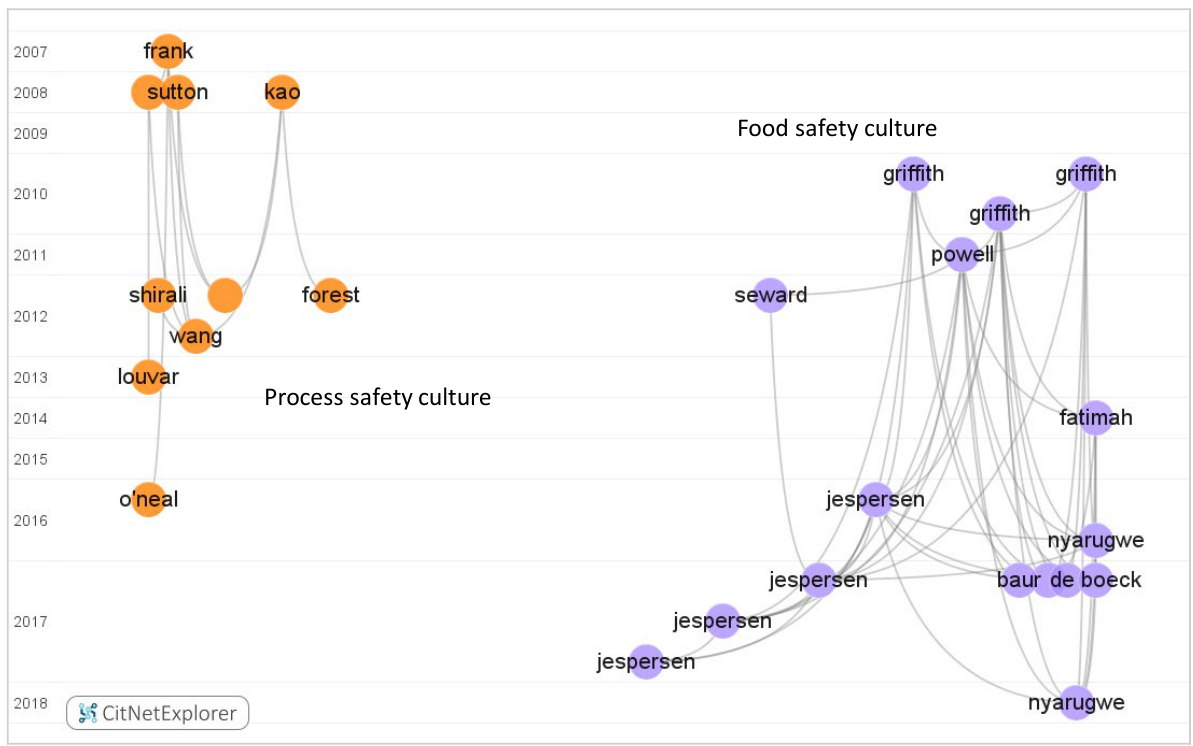
Figure 12. Direct citations network for process safety culture and food safety culture: 10 papers on process safety culture and 16 papers on food safety culture. See Supplementary Material Table S3 for details. (Generated by CitNetExplorer; see Section 2.2 for references.)